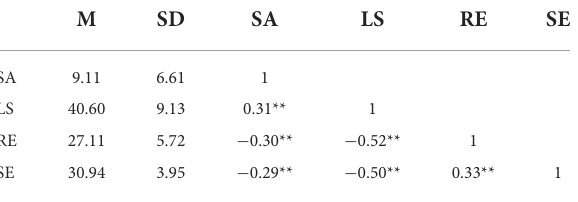
TABLE 2 Descriptive statistics and correlation analysis of each